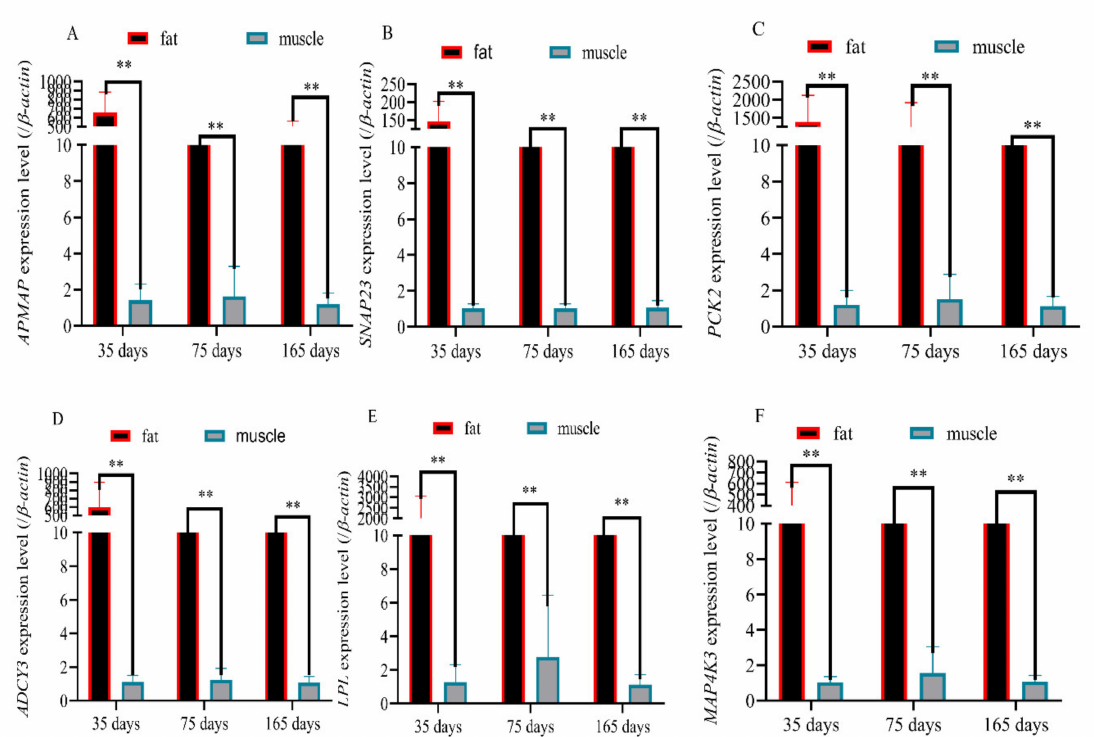
Figure 5. qPCR results of the 6 differentially m 6 A-modified genes in muscle and adipose tissue samples. ( A ) Expression levels of the APMAP gene in the muscle and adipose tissue of 35-, 75-, and 165-day-old Rex rabbits; ( B ) expression levels of the SNAP23 gene in the muscle and adipose tissue of 35-, 75-, and 165-day-old Rex rabbits; ( C ) expression levels of the PCK2 gene in the muscle and adipose tissue of 35-, 75-, and 165-day-old Rex rabbits; ( D ) expression levels of the ADCY3 gene in the muscle and adipose tissue of 35-, 75-, and 165-day-old Rex rabbits; ( E ) expression levels of the LPL gene in the muscle and adipose tissue of 35-, 75-, and 165-day-old Rex rabbits; ( F ) expression levels of the MAP4K3 gene in the muscle and adipose tissue of 35-, 75-, and 165-day-old Rex rabbits (“**”, p ≤ 0.01).